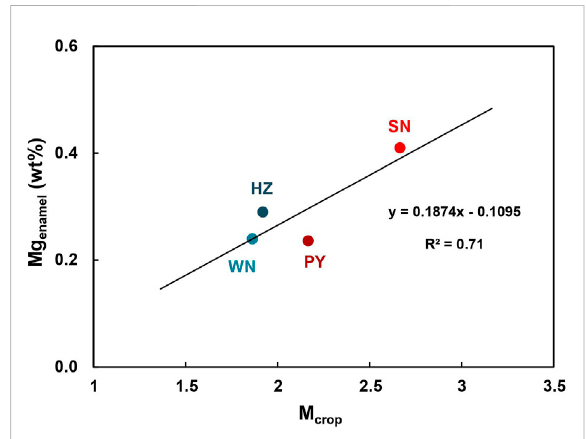
FIGURE 5 Relationship between M crop and Mg enamel . Regional M crop is measured by the local crop yield structure. Detailed calculation is referred to Table